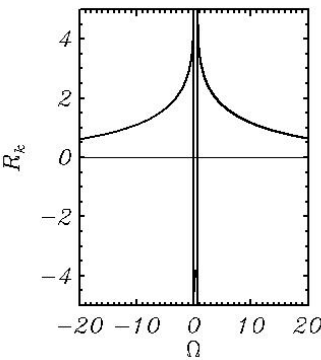
Ω . Function R ( Ω ) is given in Figure ( ) Ω R Ω is given in Figure 4. Dependence of R on the nondimensional frequency . Function